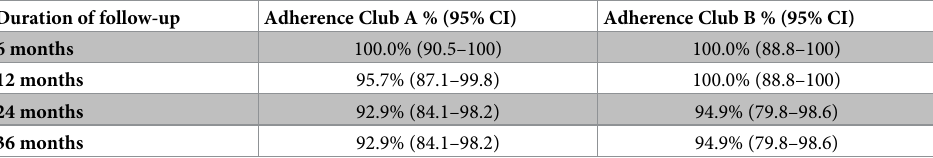
Table 6. Suppressive adherence rates at various intervals of the two sampled adherence